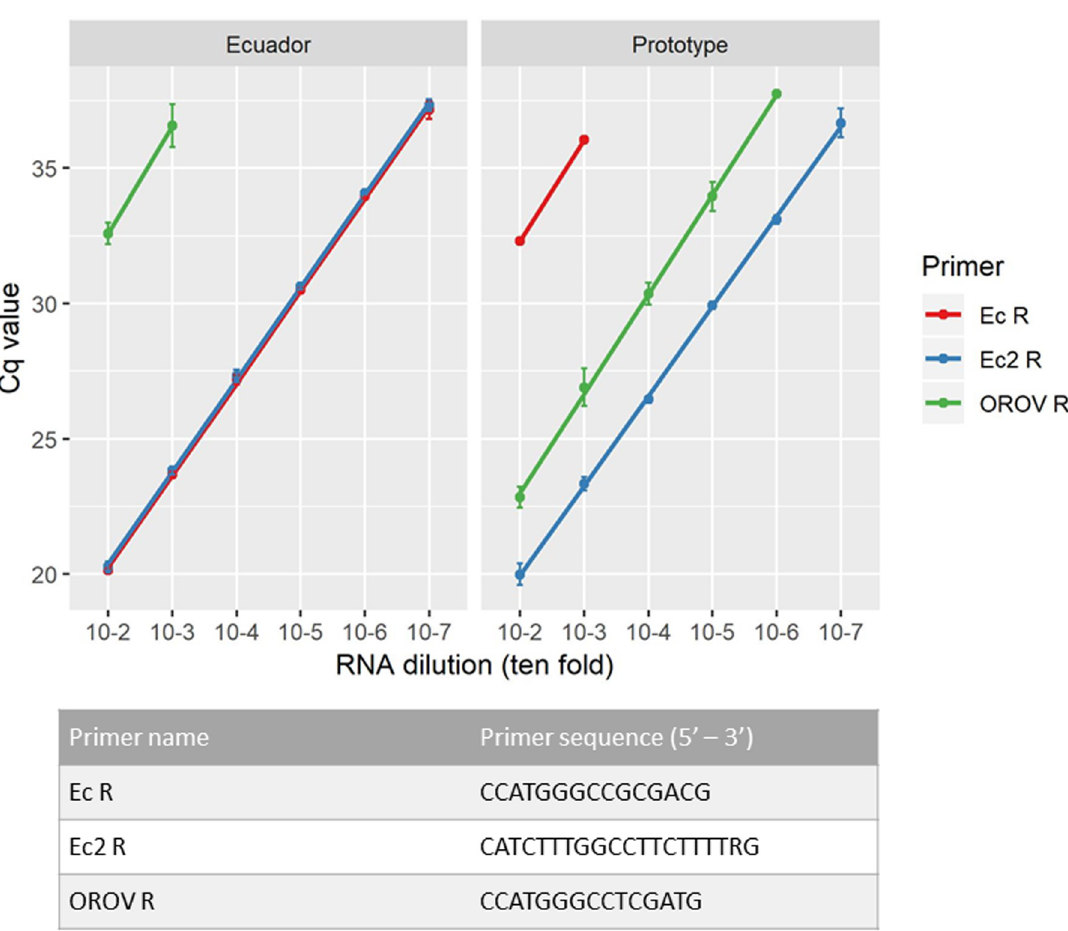
Fig 1. Sensitivity analysis of three reverse primers used in the qRT-PCR assay. Cq values are shown for ten-fold serial dilutions of OROV RNA, either from the prototype strain (GenBank KP026181.1), or the Ecuadorian strain OROV/EC/Esmeraldas/087/2016 (GenBank MF926352.1). Three separate experiments were performed, from which the means (plotted as data points) and standard deviations (indicated by error bars) were calculated. Reverse primer sequences (5’–3’) are given in the embedded